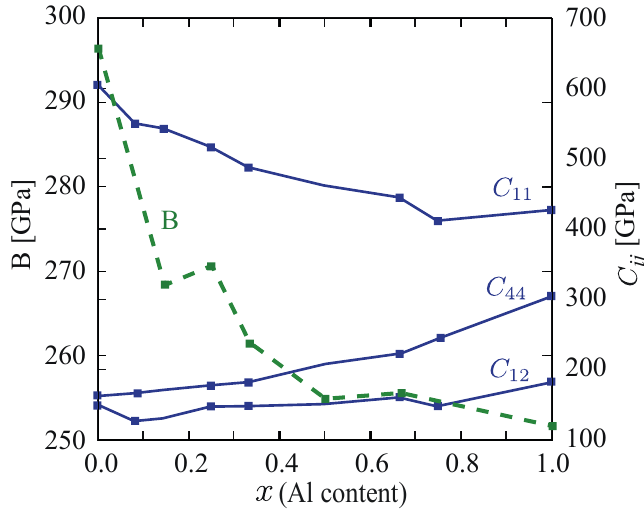
Figure 6. Calculated bulk modulus B and elastic stiffness constants, C c-Ti Al N as a function of fraction x of AlN 1−x x